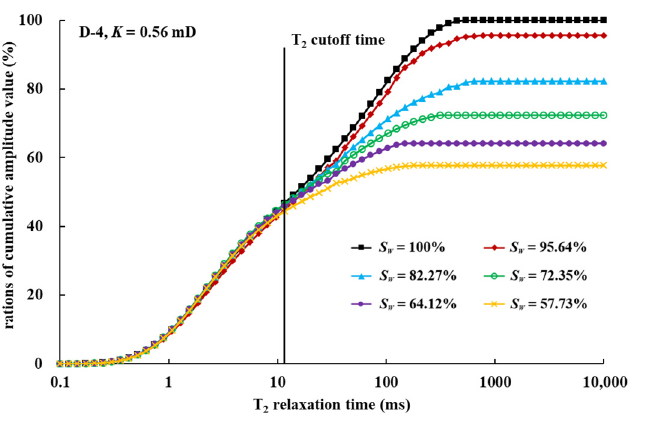
Figure 3. T 2 spectrum accumulation curve of core plug D-4 under different water saturation.